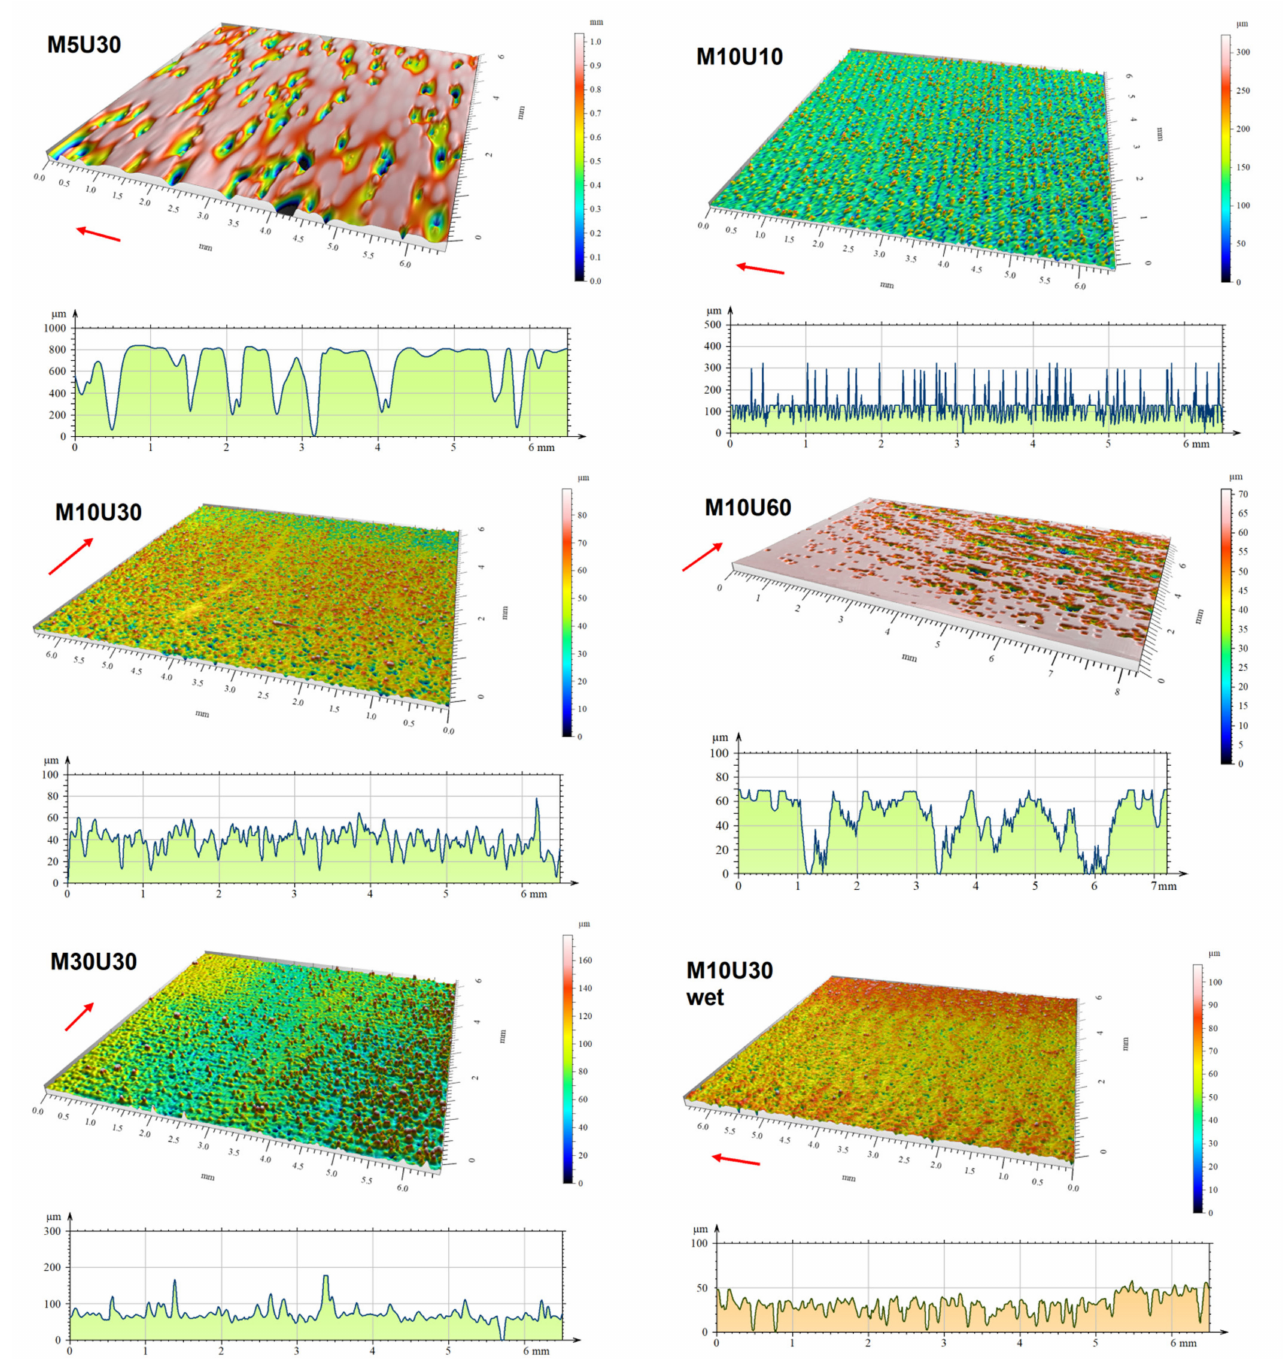
Figure 6. Digital images of the surface sections of individual sample types, made on an optical profilographometer, and representative profiles for each image. The red arrow indicates the direction of layer growth in the sample, which is also the direction of the